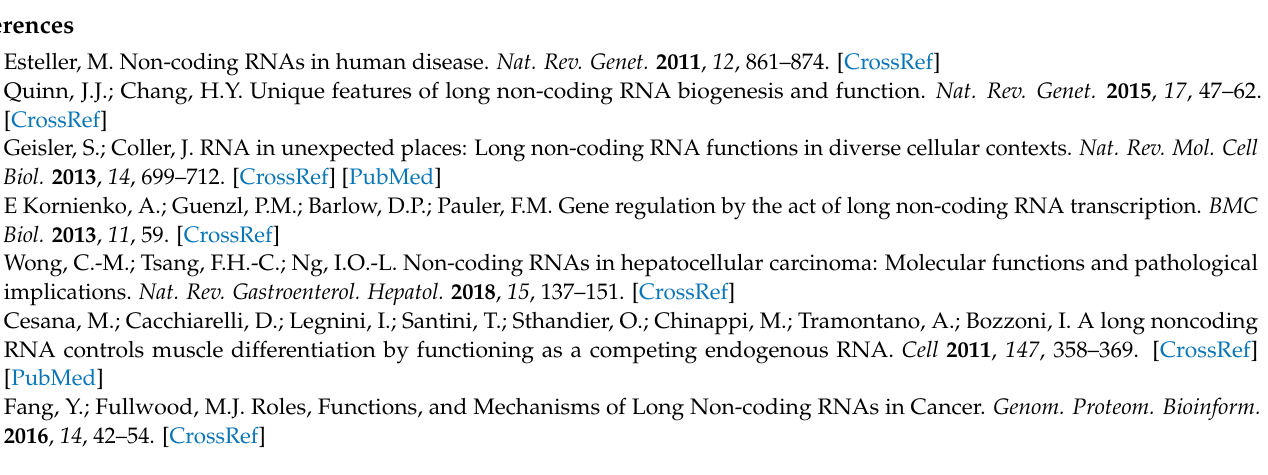
Figure S3: Analysis of the tumor cell apoptosis rate in different groups (TUNEL staining). Figure S4: Figure S5: Au–shRNA NCs to achieve biological effects for tumor mice imaging and theranostics. Figure S6: Tissue sections of major dissected organs from different treatment groups were stained with H&E. Table S1: Correlations between MALAT1 expression and clinicopathological characteristics in 30 HCC tissues. Table S2: Sequences of shRNA and lncRNA primers. Table S3: The antibodies employed for western blot